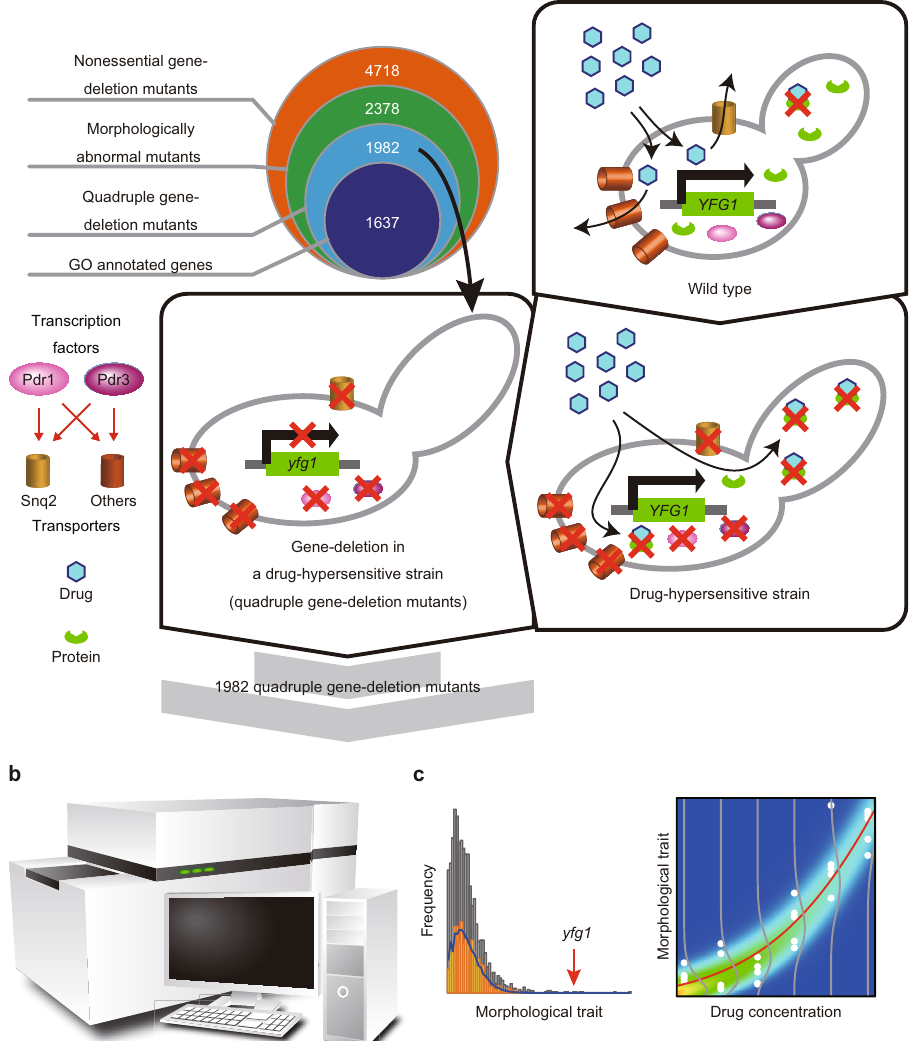
Fig. 1 Schematic illustration of the new platform for morphological pro fi ling in yeast. a Selection of genes deleted in a drug- hypersensitive strain. Haploid mutant strains in which each gene was individually deleted in a drug-hypersensitive strain with a triple-deletion genetic background were constructed for 1637 non-essential genes with GO annotation and used for the morphological pro fi ling and functional annotation of chemical compounds (blue circle in top left panel). Of the 4718 non-essential genes in the yeast genome (orange circle in top left panel), 2378 genes (green circle in top left panel) were selected as morphologically important genes. Among 1982 quadruple mutants (cyan circle in top left panel) successfully constructed by gene deletion in a drug-hypersensitive strain (3 Δ ; pdr1 Δ pdr3 Δ snq2 Δ , middle panel), 1637 genes had GO annotation. b High-throughput microscopy system coupled with the image-processing system CalMorph. Fluorescence microscope images of the yeast quadruple deletion collection and drug-treated yeast cells were acquired by HT microscopy and subjected to the image-processing program CalMorph (bottom left panel) to quantify morphological features of 501 traits. c Application of a generalized linear model to predict biological processes targeted by the bioactive compounds. Morphological data of the quadruple mutants and drug-treated cells were normalized and subjected to analysis with a GLM to predict biological processes targeted by the bioactive compounds (bottom right BTZ can be inferred by comparing the morphological changes induced by the compound with the morphologies of yeast gene- deletion mutants. Likewise, cells treated with HU were most similar to a deletion of RRM3 , which encodes a 5 ′ -to-3 ′ DNA helicase that affects multiple cellular DNA replication and repair processes (Supple- mentary Fig. 1a and Supplementary Data 3). Cells treated with MMS were most similar to a deletion of BRE1 , which encodes a ubiquitin-protein ligase involved in double-strand break repair via homologous recombination (Supplementary Fig. 1b and Supple- mentary Data 4). Cells treated with BML were most similar to a